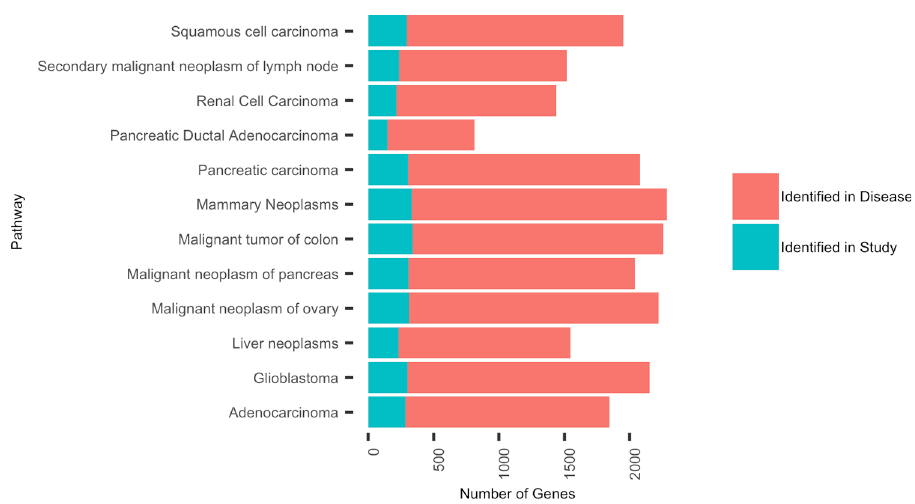
Fig 1. Differential expression analysis shows enrichment for multiple relevant pathways. For all fdr corrected differentially expressed genes, an enrichment analysis was performed using ToppFunn, and relevant pathways were plotted.